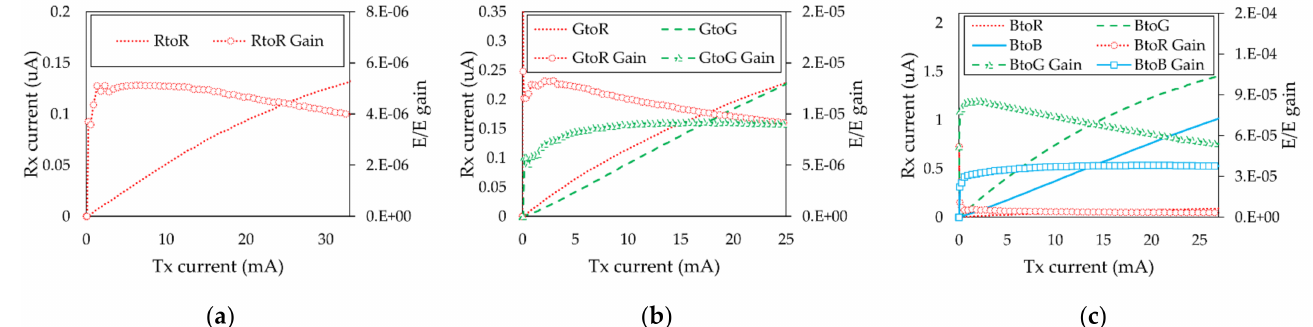
Figure 6. Output current and channel DC gain with respect to the input current when transmitter color is ( a ) red, ( b ) green, and ( c ) blue. The reason why RtoG, RtoB, and GtoB cases are not displayed is that the receiver LEDs cannot receive longer wavelength signals than the wavelength they were designed to as a transmitter.